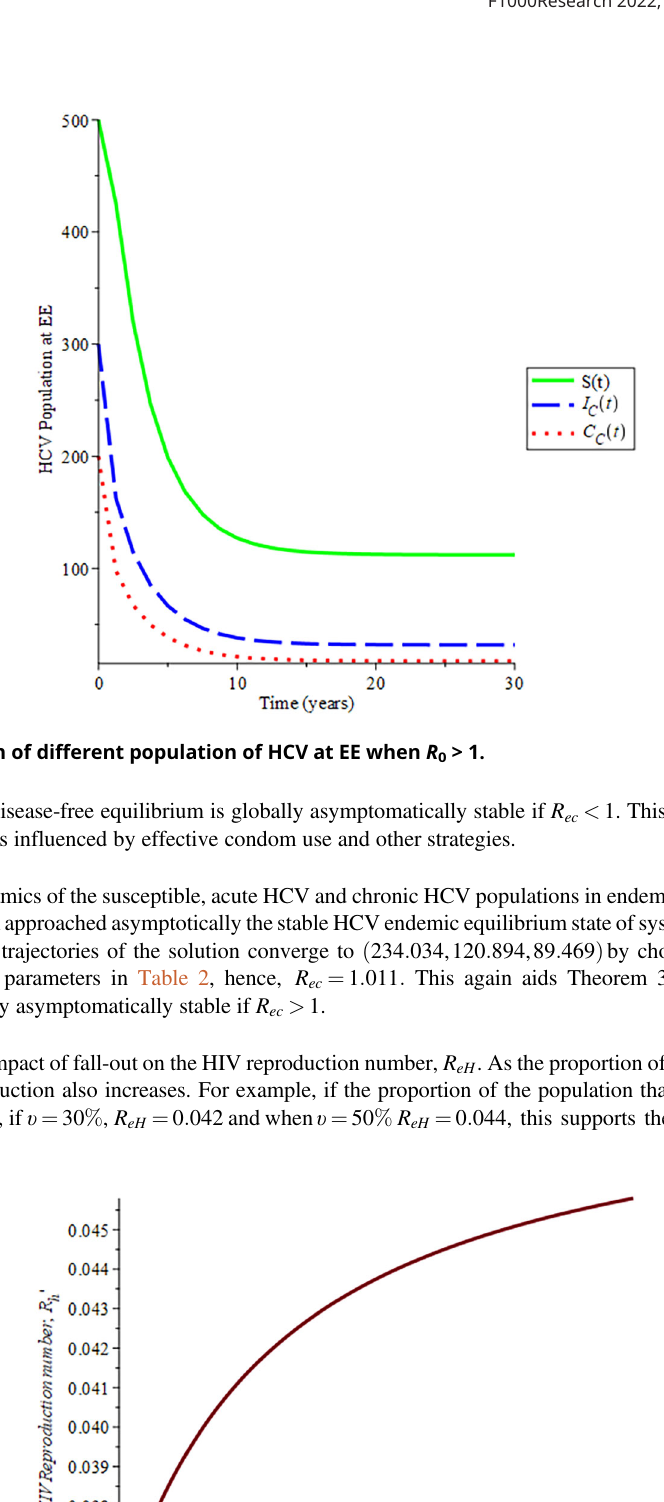
Figure 6. Impact of HIV treatment fall-out population on HIV reproduction number.